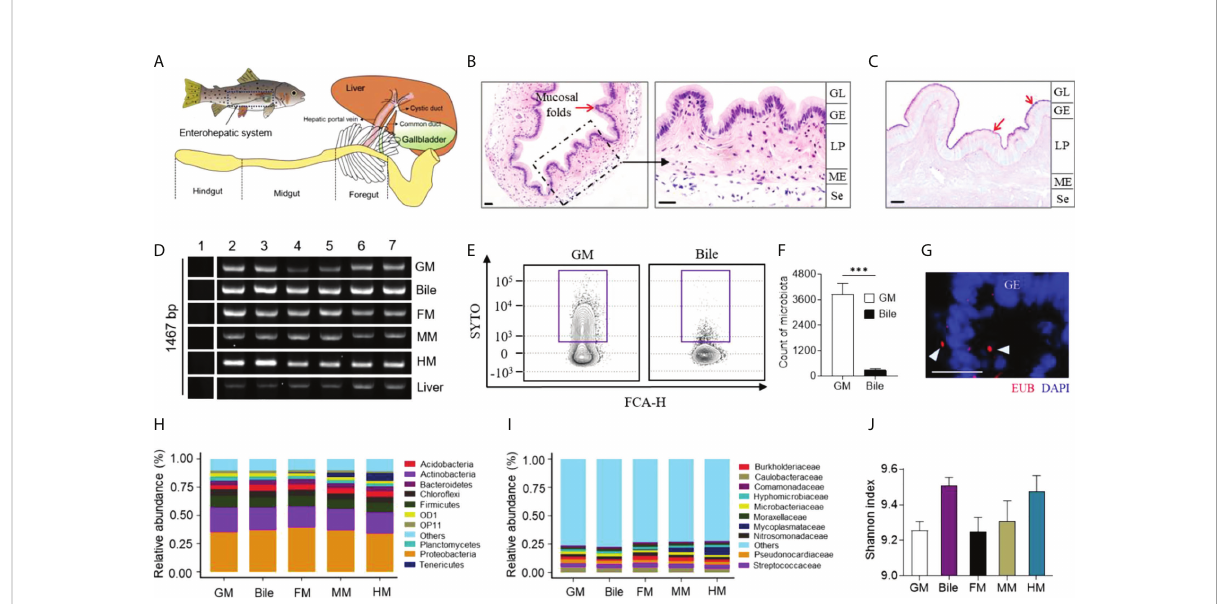
FIGURE 1 Characterization of microbiota composition in GM, bile and gut mucosa of naïve rainbow trout ( Oncorhynchus mykiss ). (A) Diagram of the enterohepatic system in rainbow trout. H & E (B) and AB-PAS (C) stain of GB organ obtained from naive rainbow trout. Red arrows indicate the reaction with AB-PAS. GL, GB lumen; GE, GB epithelium; LP, lamina propria; ME, muscularis externa; Se, serosa. Scale bar, 20 µm. (D) Real-time PCR assay analyzed the expression of 16S rRNA gene (27F and 1492R) from GM, bile, FM, MM, HM and liver of trout ( n = 6 fi sh per group). Lane 1, blank control; Lane 2-7, samples from different individuals. (E) Representative fl ow cytometry staining of microbiota from trout GM (left panel) and bile (right panel) with SYTO BC Green. (F) Counts of positive microbiota in the GM and bile samples from naïve rainbow trout ( n = 8 fi sh per group). Statistical differences were evaluated by unpaired Student ’ s- t test. (G) Detection of bacteria by fl uorescence in situ hybridization in GB cryosections from naive fi sh. Eubacteria were detected with Cy3-EUB338 oligoprobe (red). Nuclei are stained with DAPI (blue). GE, GB epithelium. Scale bars, 20 m m. Mean relative abundance at the phylum (H) and family (I) levels of the GM, bile, FM, MM, and HM bacterial community ( n = 8 fi sh per group). (J) Histogram showing the Shannon diversity index of GM, bile, FM, MM, and HM microbial communities from naive fi sh ( n = 8 fi sh per group). Statistical differences were performed by Kruskal-Wallis test. Data are representative of two independent experiments (mean ± SEM). ***p <